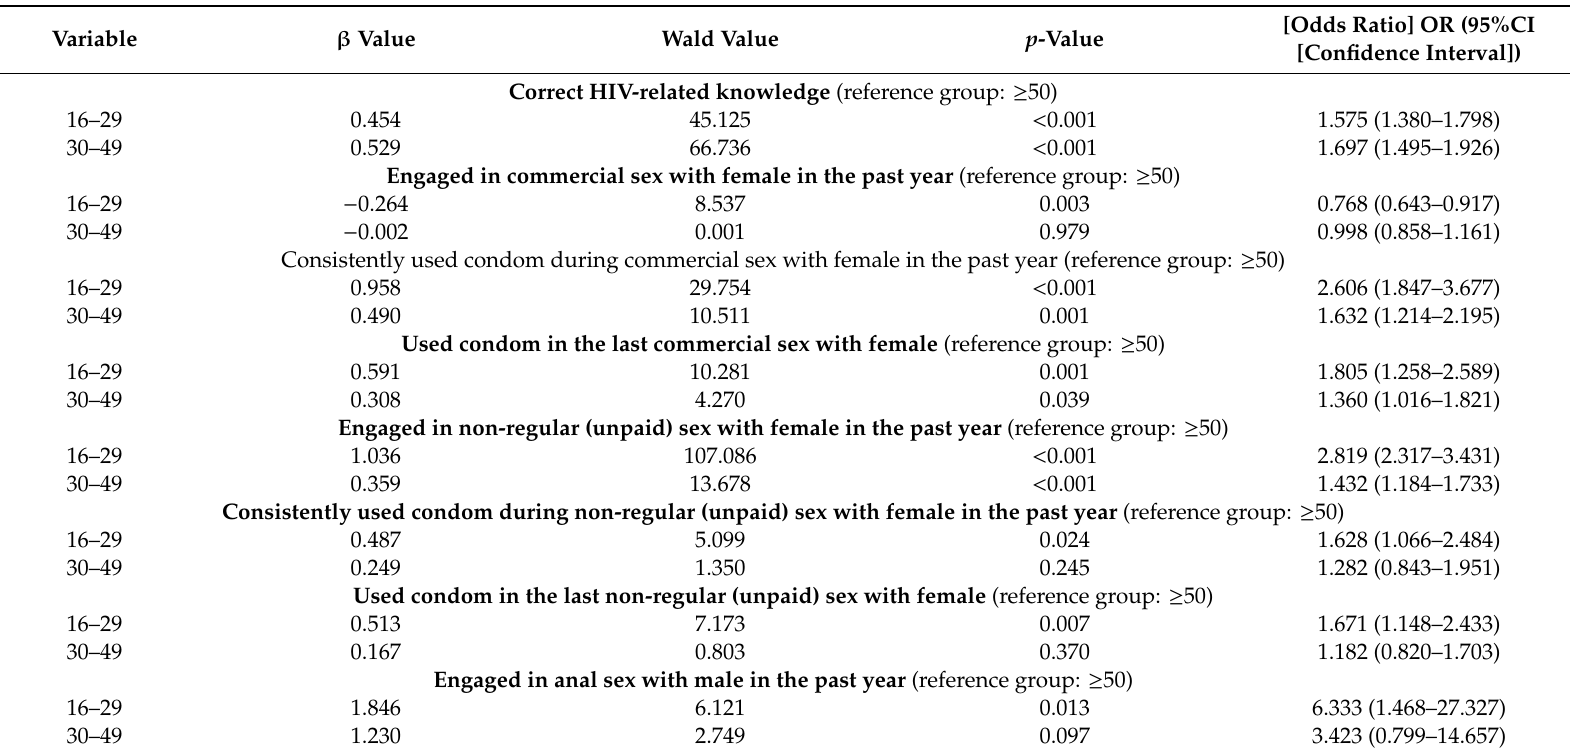
Table 3. The distinctions of HIV-related knowledge and behaviors between di ff erent age